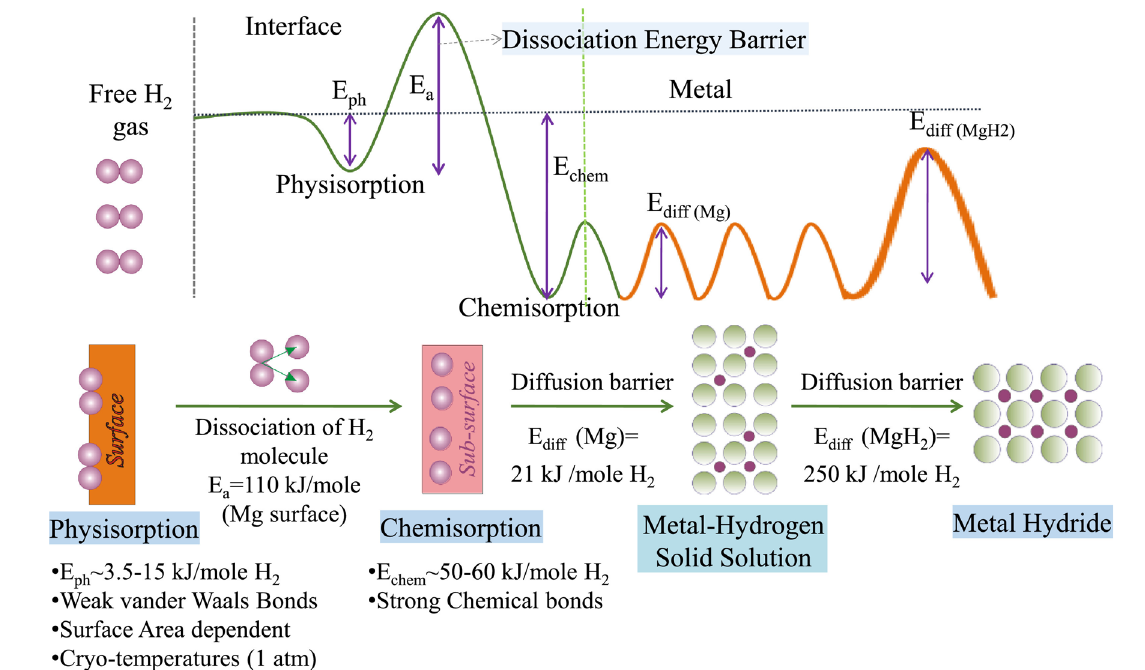
Fig. 2 Schematic diagram describing continuous energy barriers in the process of hydrogen absorption (up) and illustration of the kinetic steps in the hydrogen storage process (down). Reproduced with permission from Ref. [54]. Copyright 2021 Elsevier